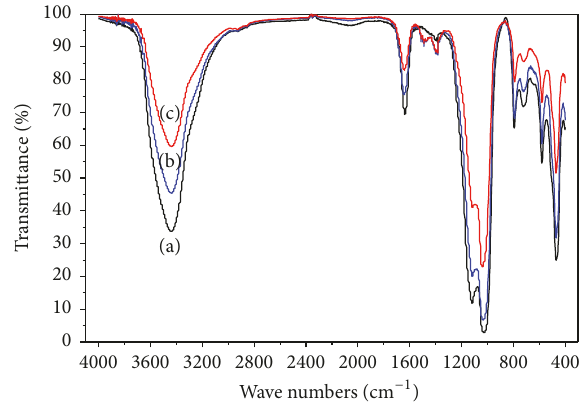
Figure 6: IR spectra of fresh and reused NaY catalysts. (a) Fresh NaY; (b) NaY after used for the first time; (c) NaY after used for the second time.